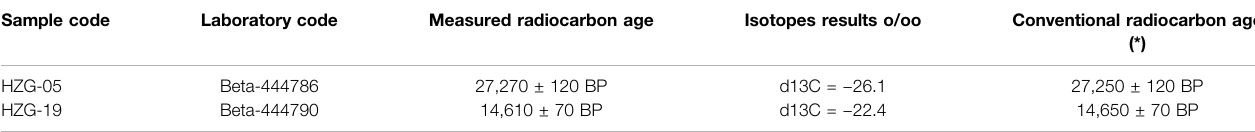
TABLE 1 | Results from the 14 C dating of samples HZG-05 and HZG-19 collected in Hazigai pro fi